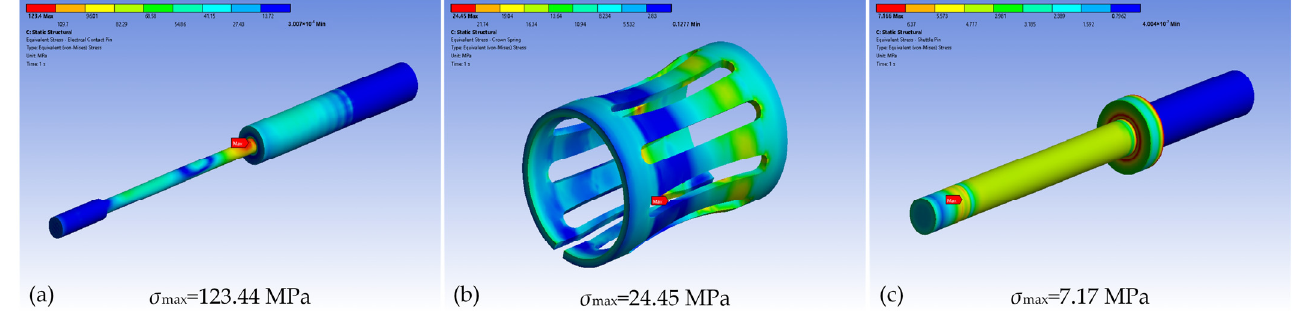
Figure 10. The thermal stress distribution of some core components of the proposed wet-mateable electrical connector: ( a ) contact pin, ( b ) crown spring, and ( c ) moveable stopper.